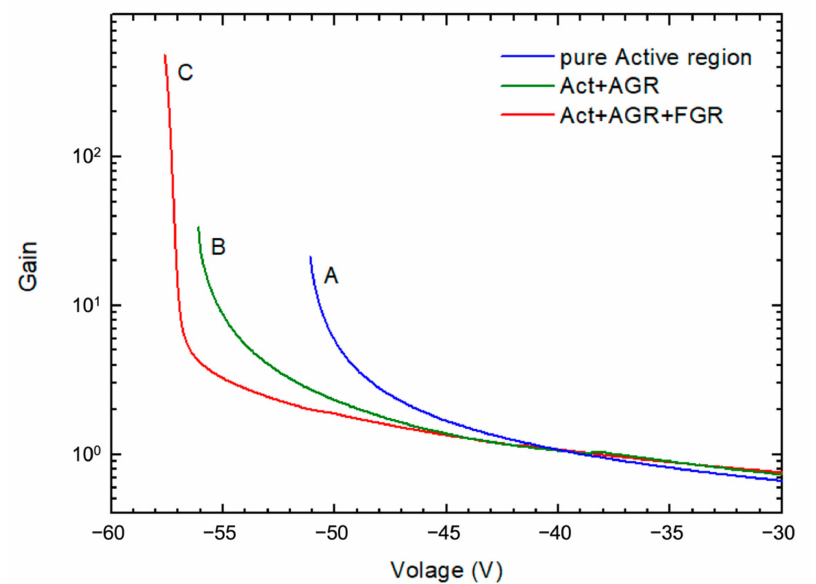
Figure 11. The gain curves obtained from the I-V curves shown in Figure 4. A, B, and C represent device A, B, and C in Figure 4.